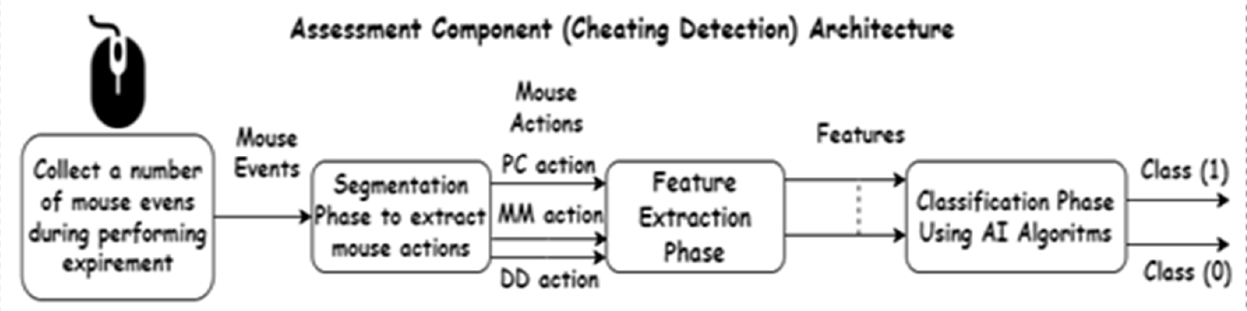
Figure 2. The architecture of the fair assessment module.